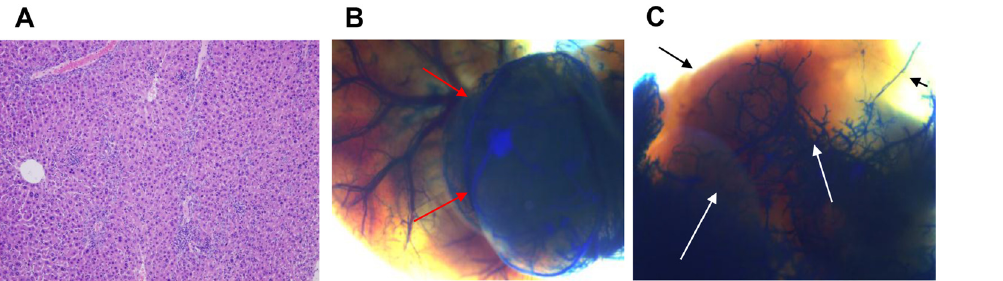
Fig 5. Latex angiography of Albumin-Cre/WW45 fl/fl mice that developed spontaneous hepatocelluar carcinomas. Representative images of (A) histologic examination (hematoxylin and eosin staining, ×100), (B) selective latex arteriography and (C) portography. The masses appeared as extremely hypervascular lesions (red arrows) on selective latex arteriography, but were devoid of portal venous perfusion (black/white arrows).